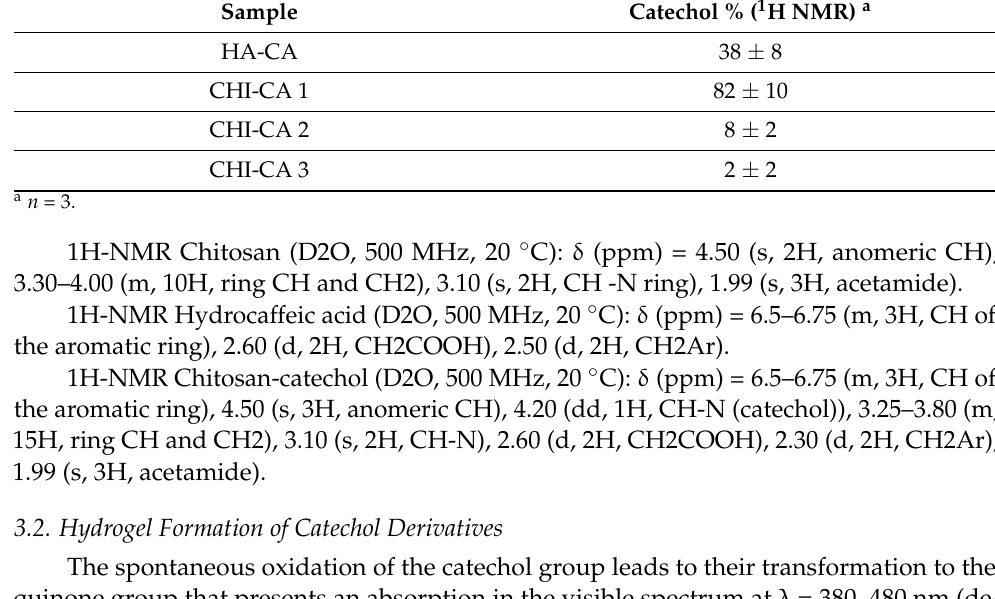
Table 1. Substitution percentages of catechol in the samples.